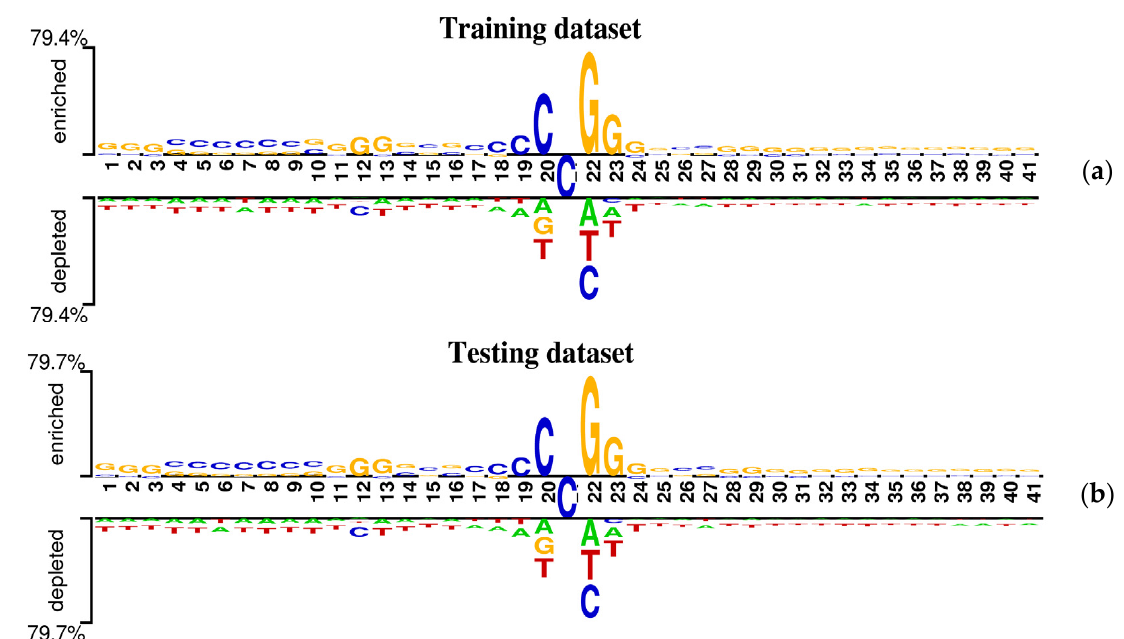
Figure 2. Demonstration of nucleotide composition preferences between positive and negative samples in the benchmark datasets. ( a ) The nucleotide distribution around 5mC sites is for the training dataset. ( b ) The nucleotide distribution around 5mC sites is for the testing dataset.